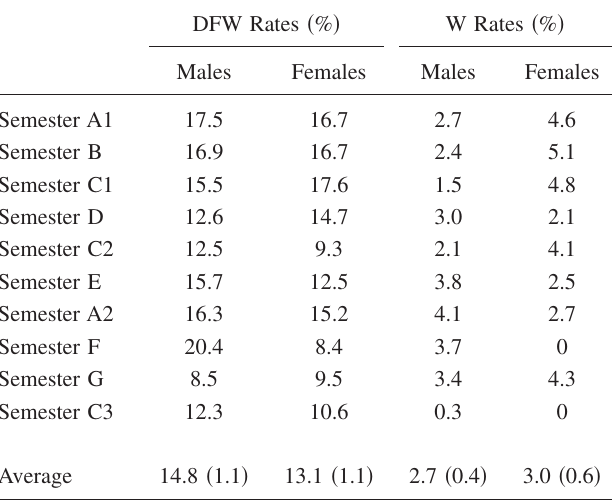
TABLE VI. DFW and W rates for Males and Females in Each Semester. The DFW rate is the percentage of students who receive a grade of D, F, or W (cid:1) withdrew from the course (cid:2) . The W rate is the percentage of students who withdrew from the course. On average, the DFW and W rates of males and females are not significantly